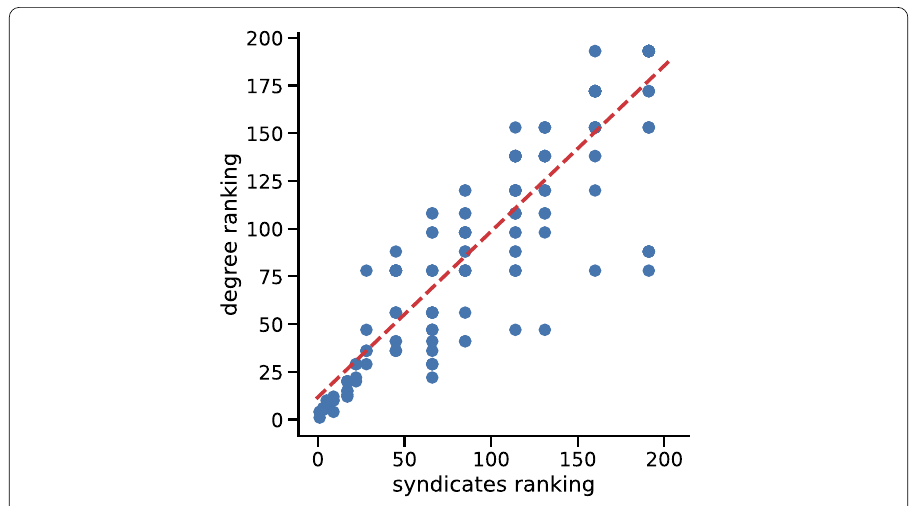
Figure 7 Scatter-plot where for each network node we show the ordering in terms of degree (vertical axis) versus the ordering in terms of connection with other mafia affiliates (horizontal axis). We added a linear fit y = ax + b where a = 0.86, b =